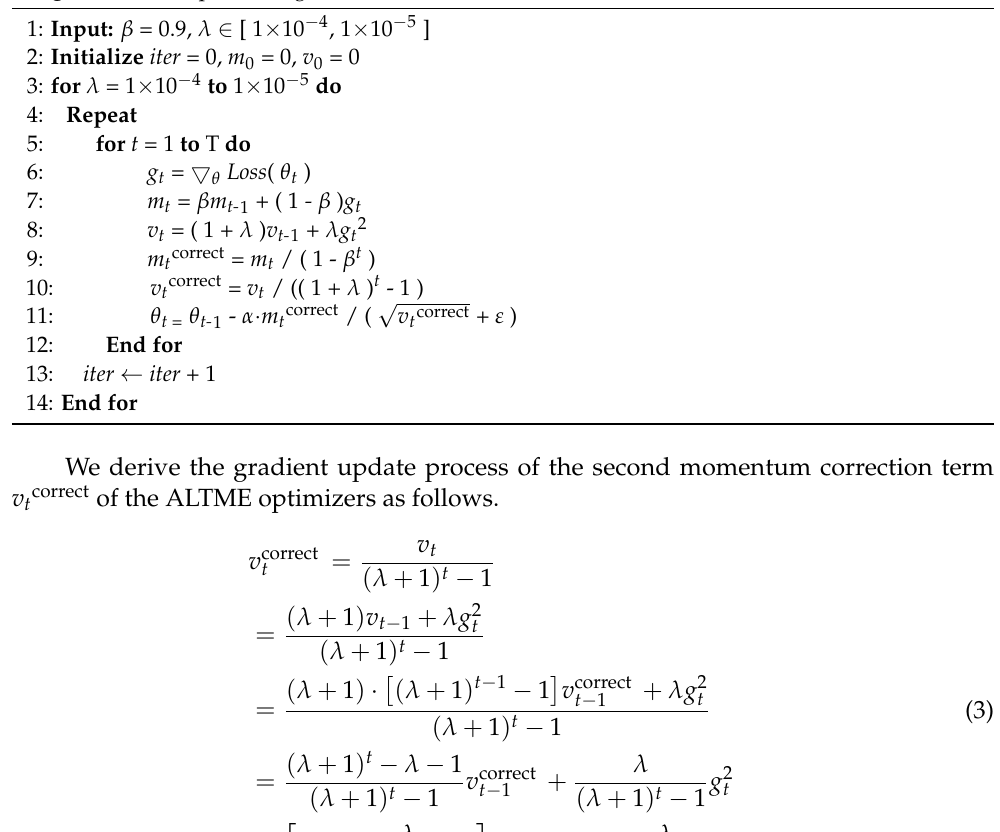
Algorithm 1 Adaptive Long-term Moment